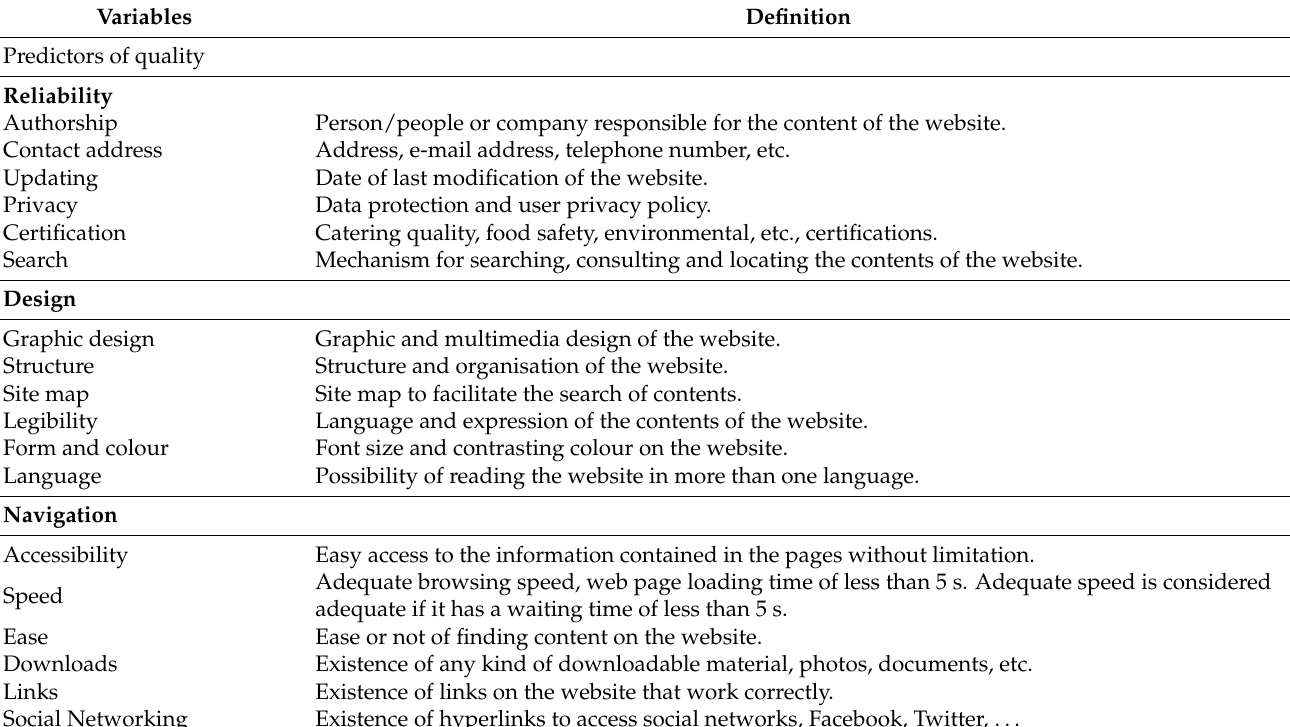
Table 4. Definition of final variables of the validated EDALCAT